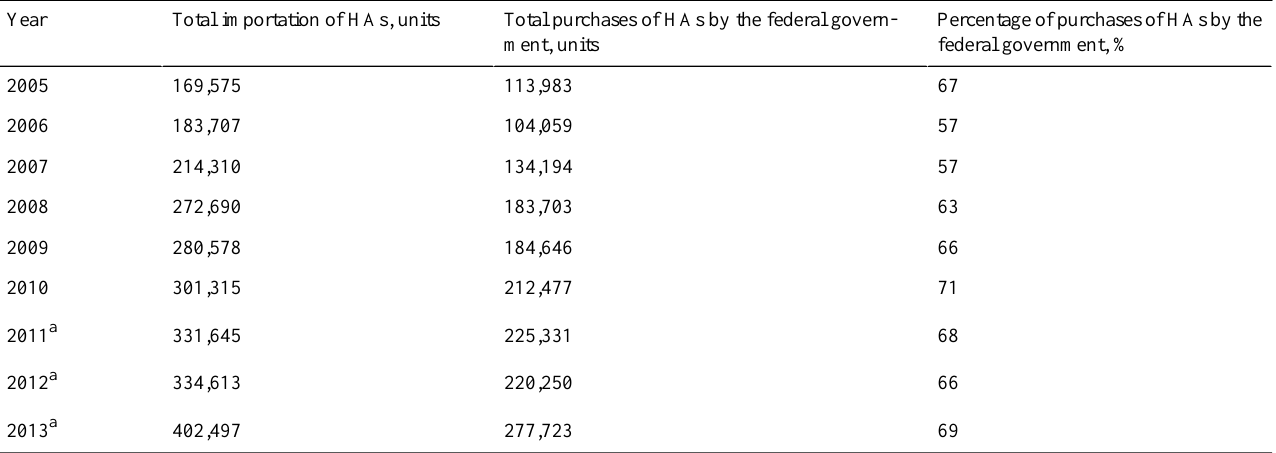
Table 2. Investments in hearing health in Brazil (Ordinance #587 and #589).